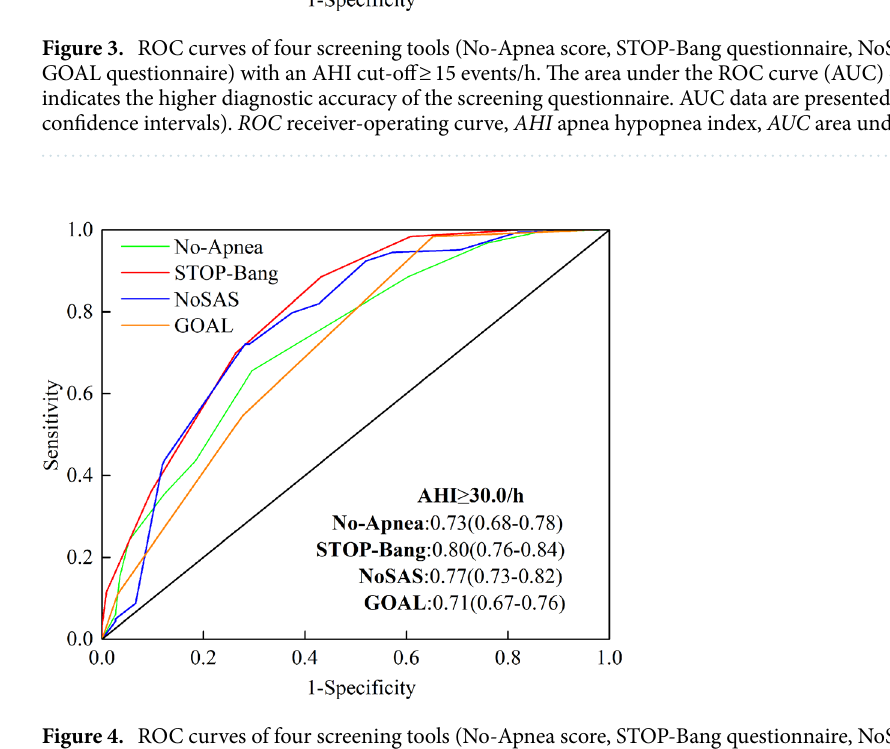
Figure 4. ROC curves of four screening tools (No-Apnea score, STOP-Bang questionnaire, NoSAS score and GOAL questionnaire) with an AHI cut-off ≥ 30 events/h. The area under the ROC curve (AUC) closer to 1 indicates the higher diagnostic accuracy of the screening questionnaire. AUC data are presented as values (95% confidence intervals). ROC receiver-operating curve, AHI apnea hypopnea index, AUC area under the